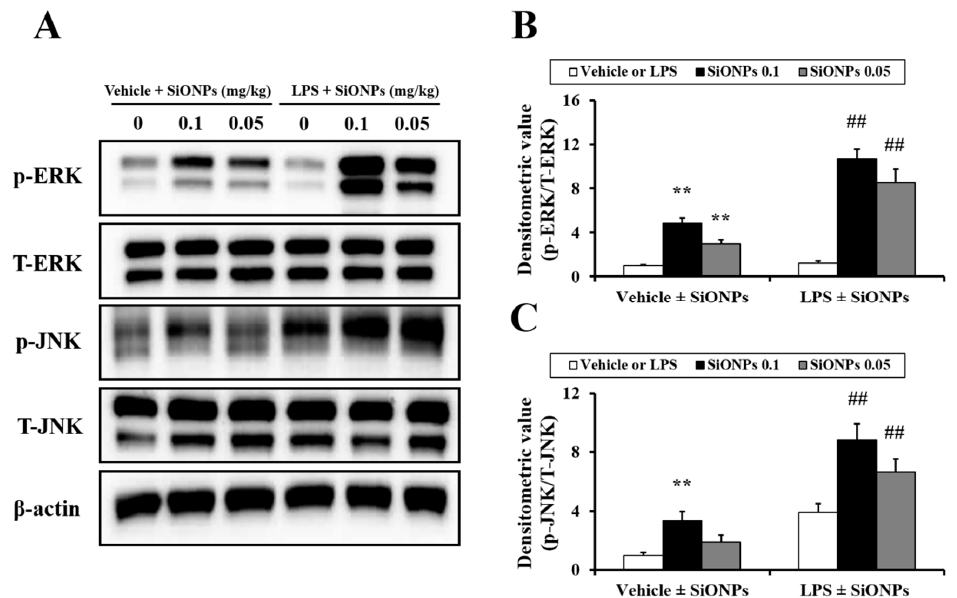
Figure 5. Effect of SiONPs exposure on ERK and JNK phosphorylation in lung tissues of each group. ( A ) ERK and JNK expression on gels. ( B ) Densitometric value of ERK phosphorylation. ( C ) Densitometric value of JNK phosphorylation. Data represent the means ± SD ( n = 5 per group). ** p < 0.01 vs. vehicle control. ## p < 0.01 vs. LPS.